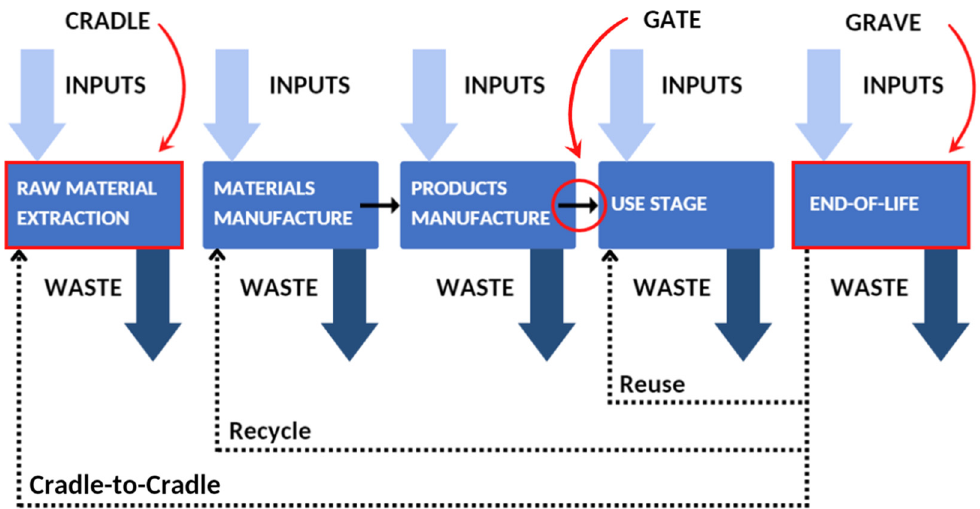
Figure 5. LCA stages diagram including Cradle-to-Grave loop.